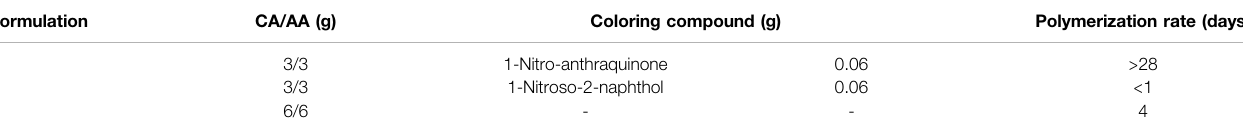
TABLE 3 | Colored n-CA